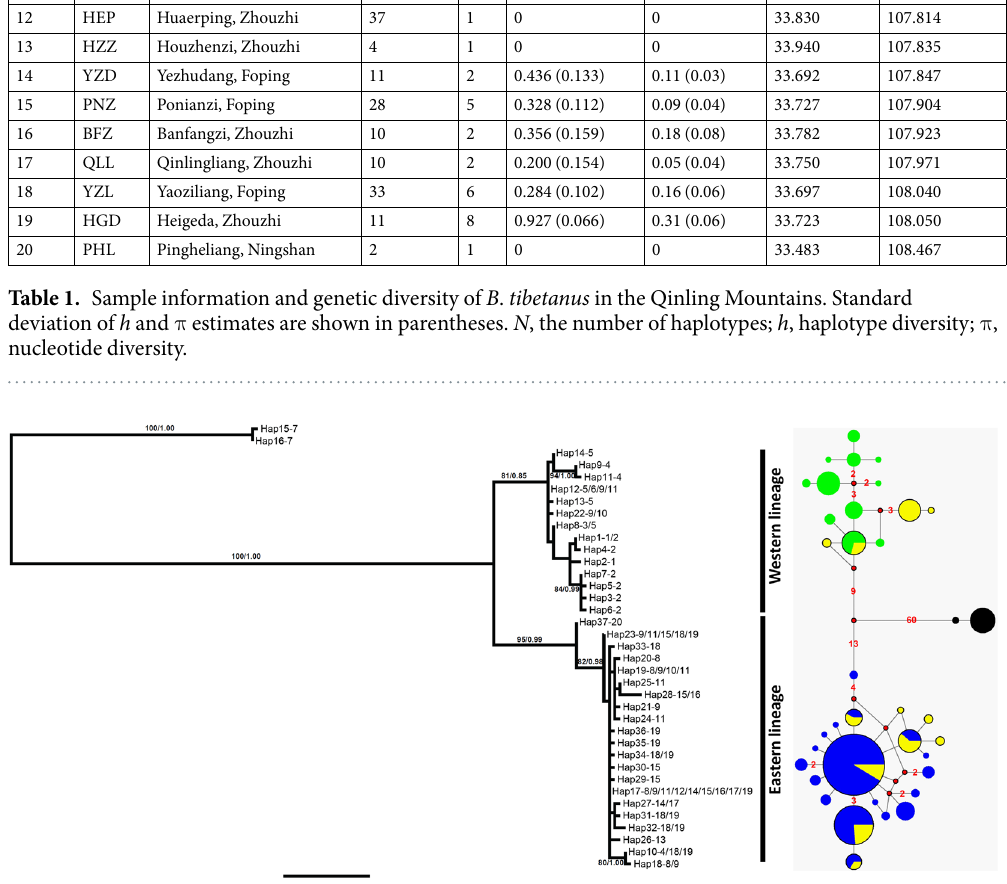
(Fig. 3). Assuming a substitution rate of 6.2 × 10 − 9 substitutions per site per year 37 , both of the two lineages showed the obvious signals of a recent expansion (50 and 10 ka for the western and eastern lineages, respectively). Ecological niche modelling. The ecological niche modelling (ENM) predicted accurately the distribution area of B . tibetanus with the average AUC (the area under the curve) for the twenty replicate runs being 0.934,